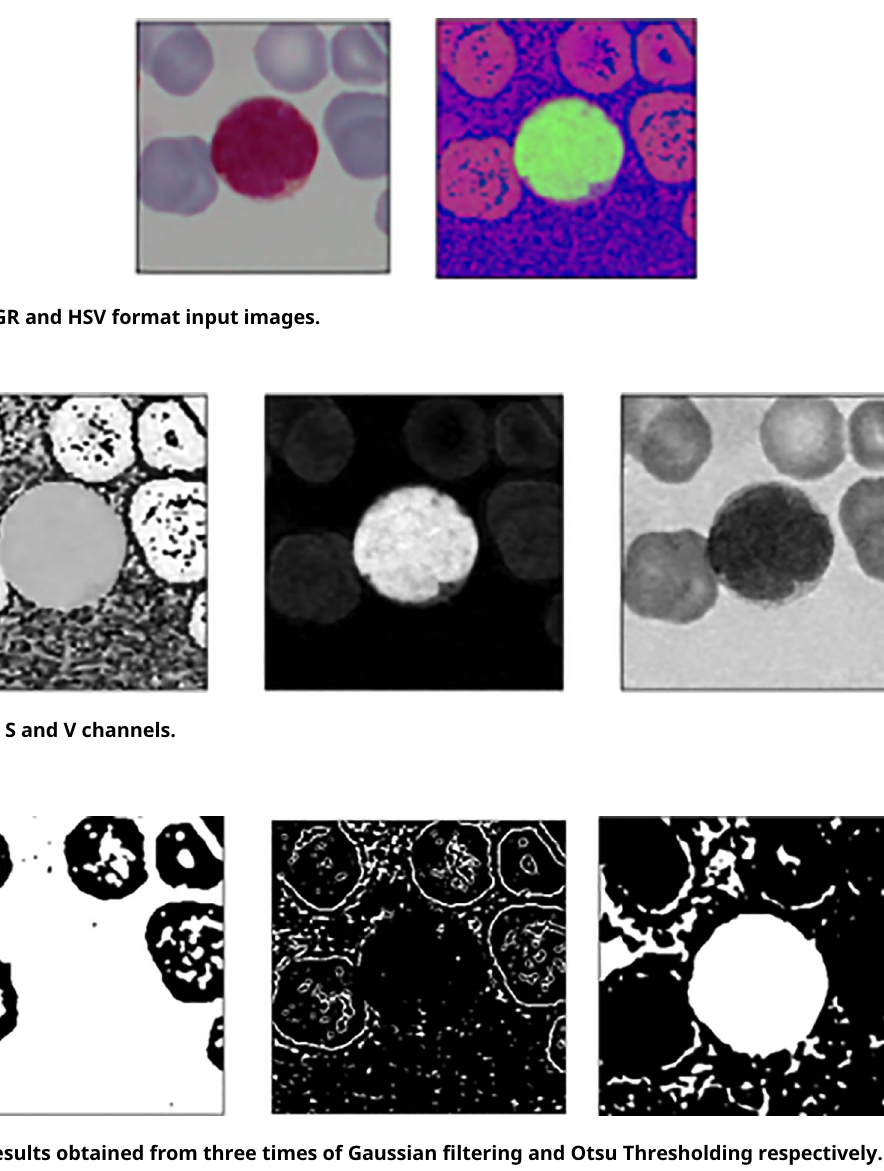
Figure 4. Results obtained from three times of Gaussian filtering and Otsu Thresholding respectively.